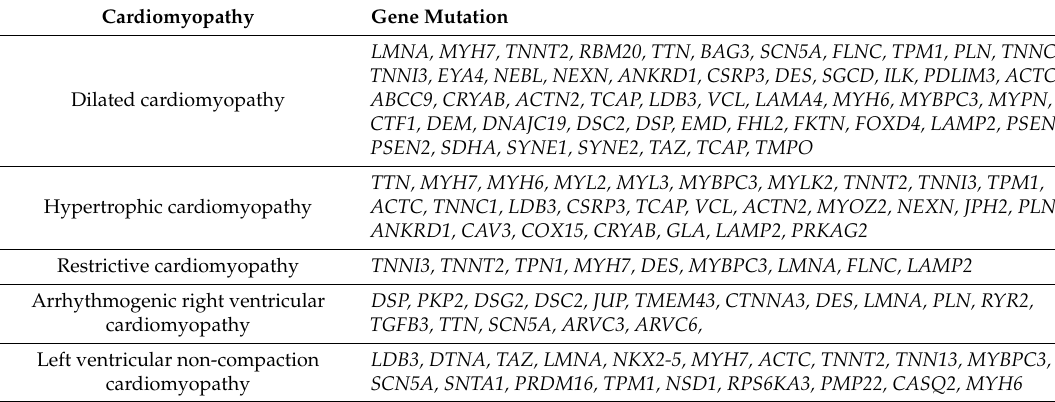
Table 2. Genetic mutations of five major